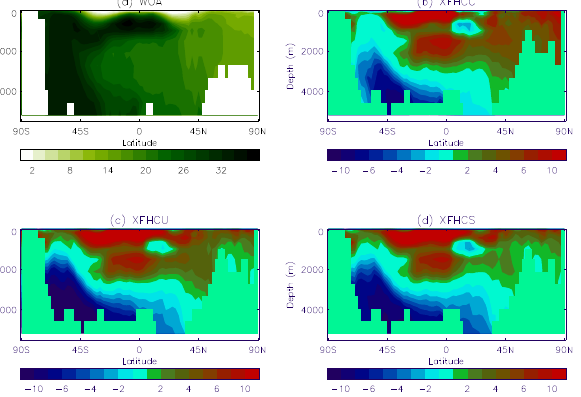
Fig. 17. As for Fig.15 but for the Pacific basin (150 ◦ E–290 ◦